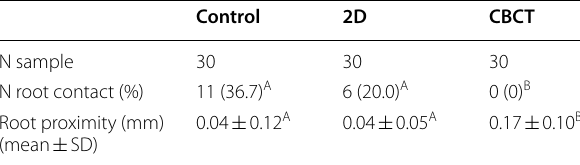
A,B Values with similar letters are not significantly different at the p